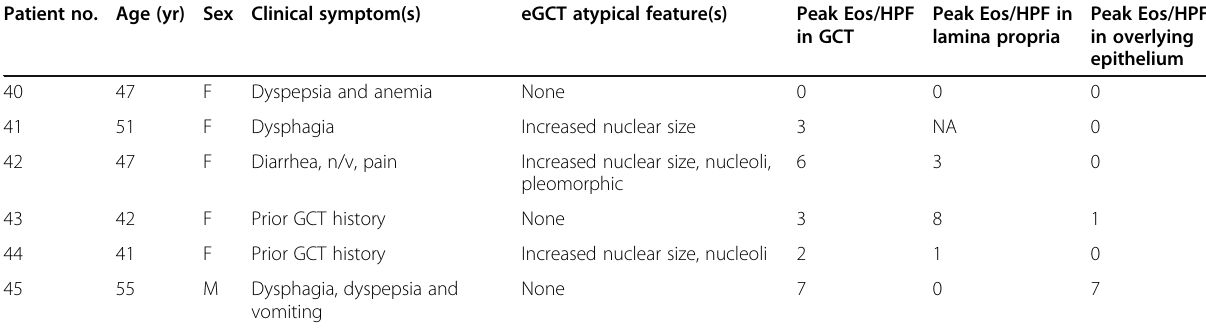
Table 1 Clinical and histologic findings of 45 patients with esophageal granular cell tumor (Continued) Patient no. Age (yr) Sex Clinical symptom(s) eGCT atypical feature(s)